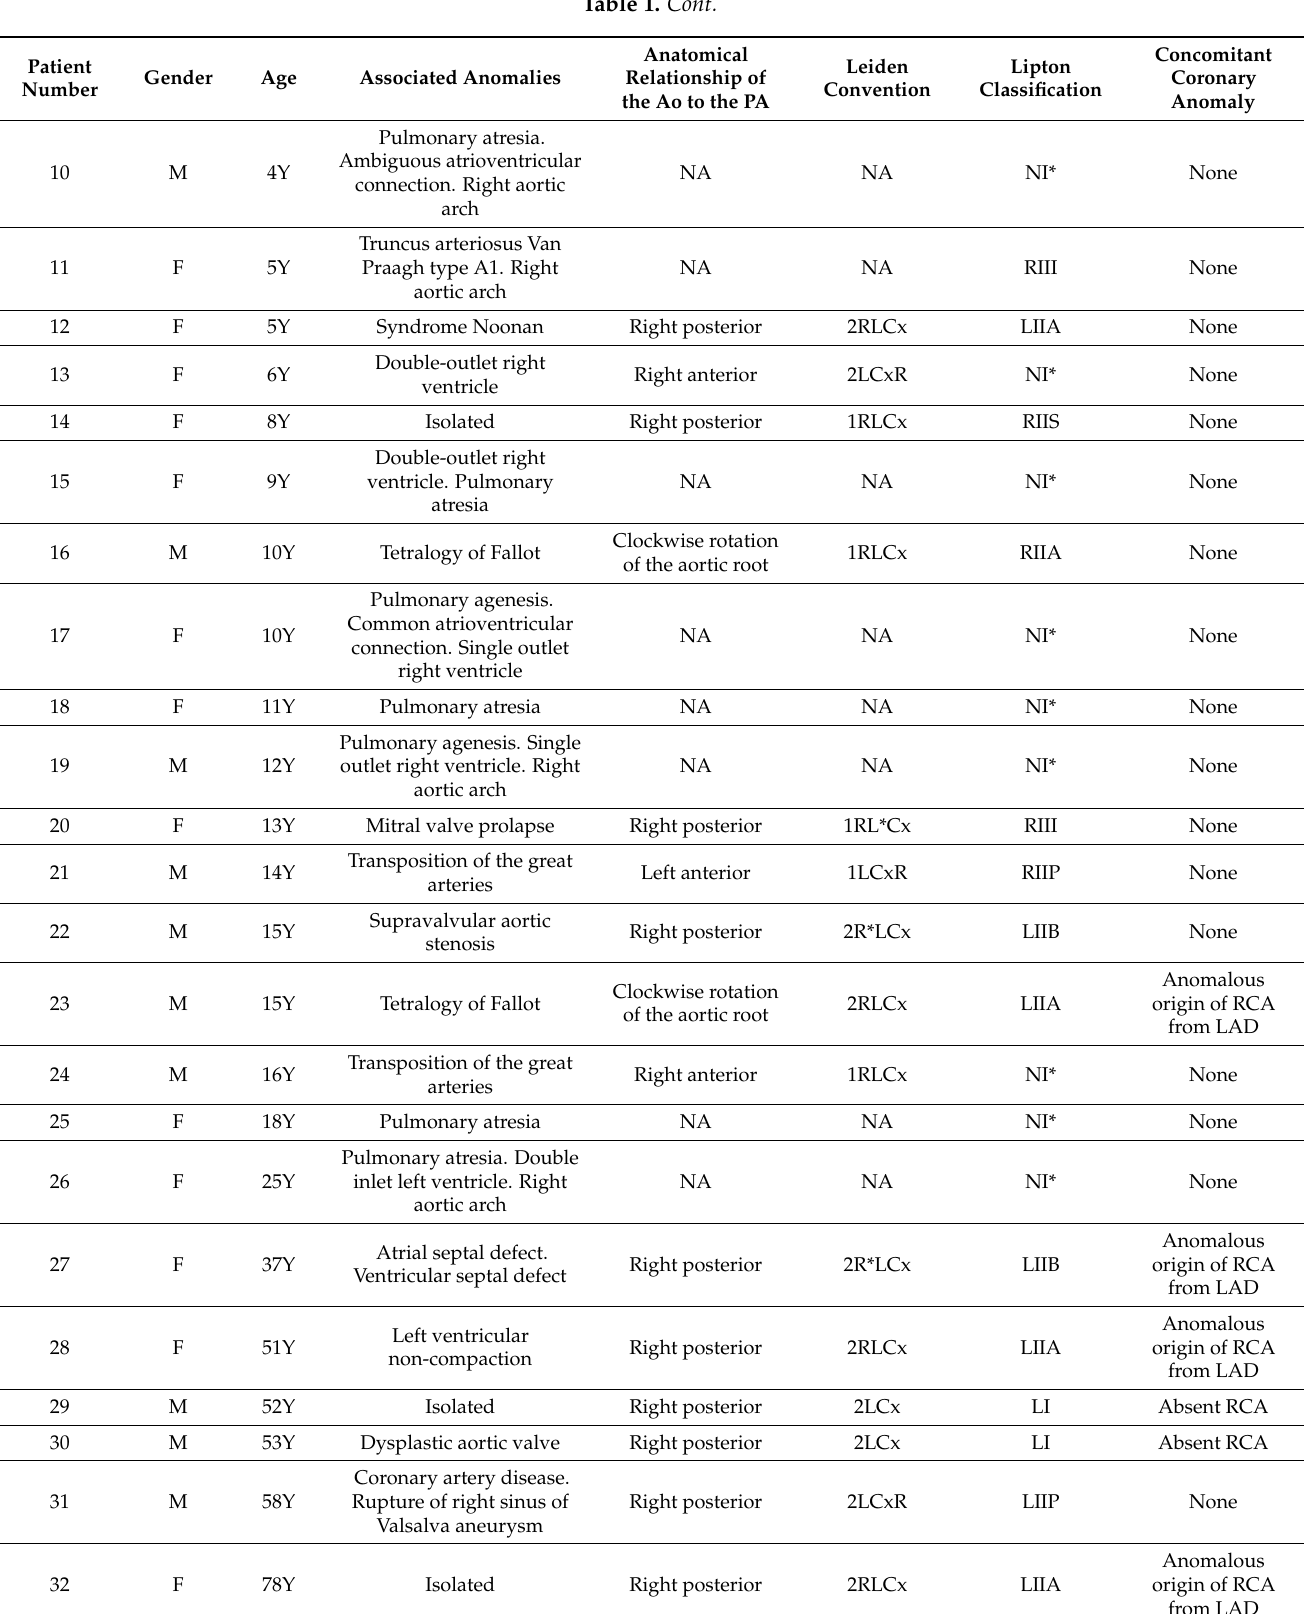
F 78Y Isolated Right posterior 2RLCx LIIA